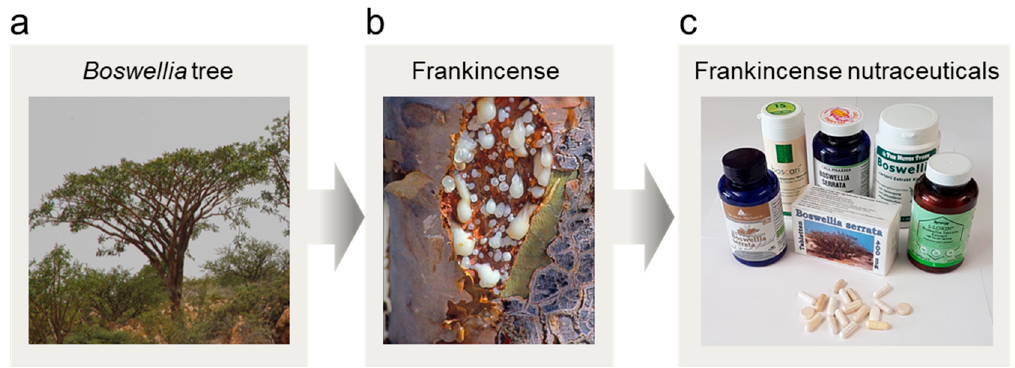
Figure 1. Production of frankincense nutraceuticals. Boswellia tree grown in Somalia ( a ), harvesting of the frankincense oleogum resin by bark incisions ( b ), commercial frankincense nutraceuticals ( c ). Pictures with permission from Georg Huber [20].